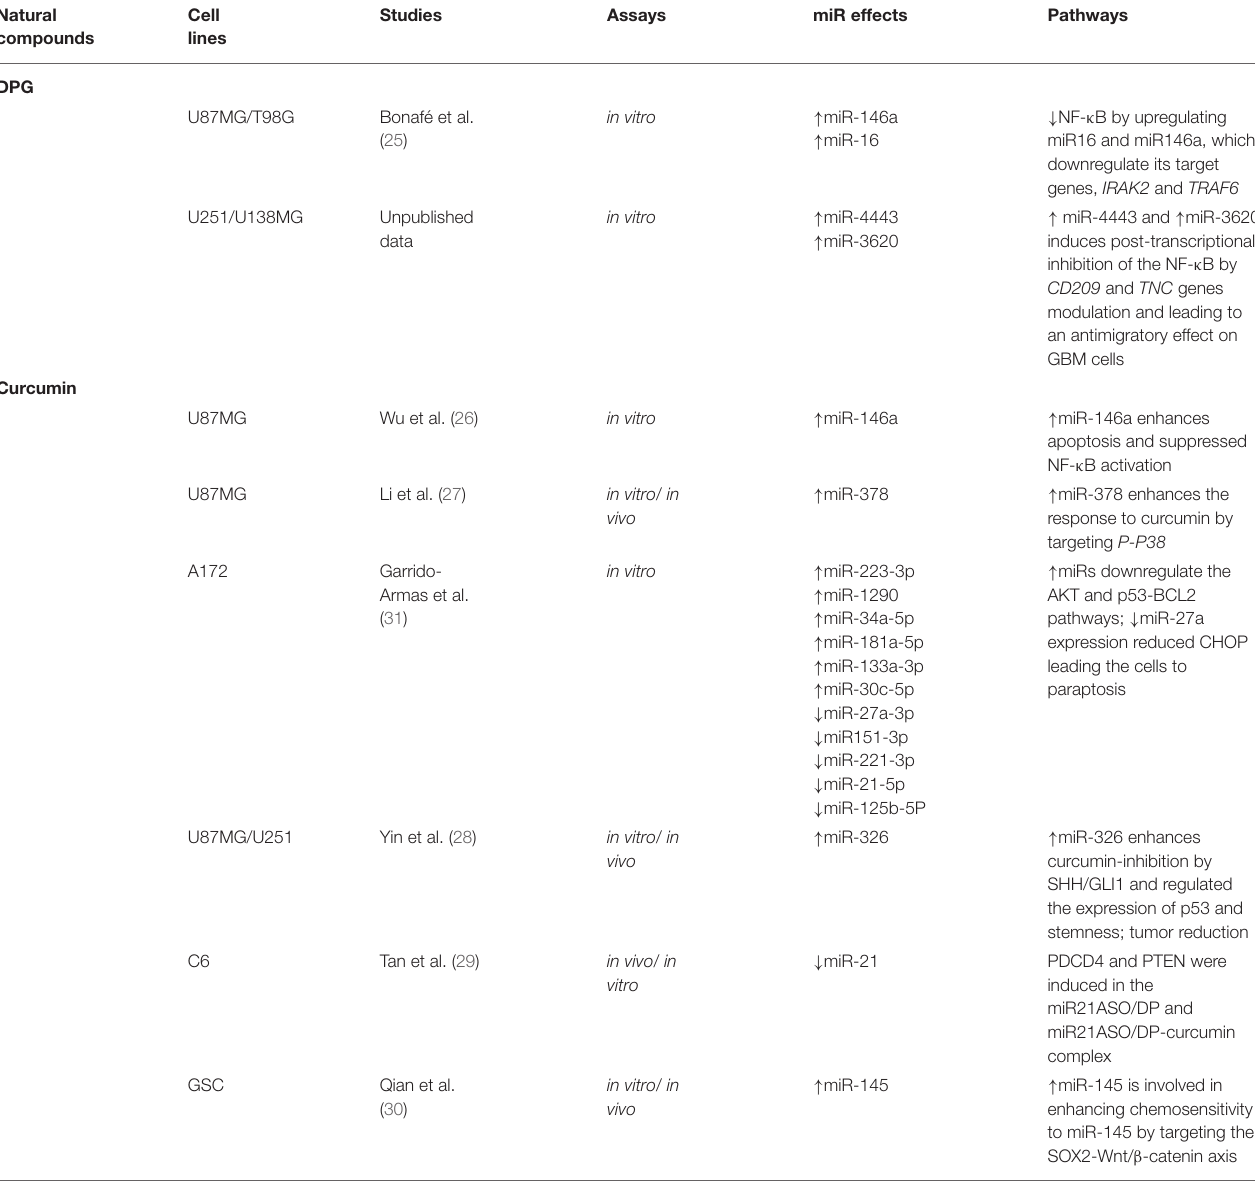
TABLE 2 | The natural compound effects on miRs in GBM cell lines (83–87, 89). Natural